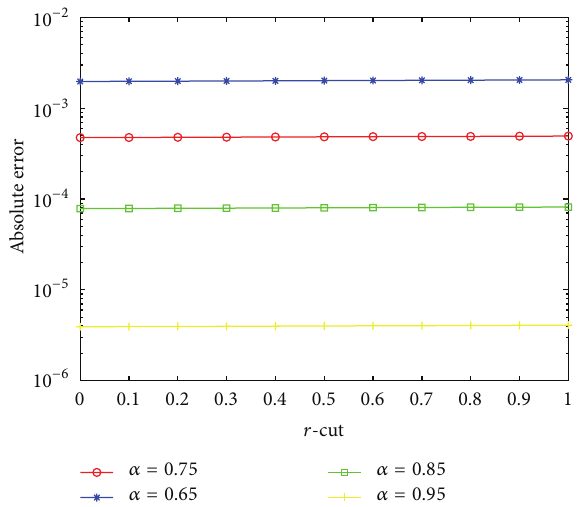
Figure 14: The absolute error for different 𝛼 of Example 62, 𝑚 = 10 .